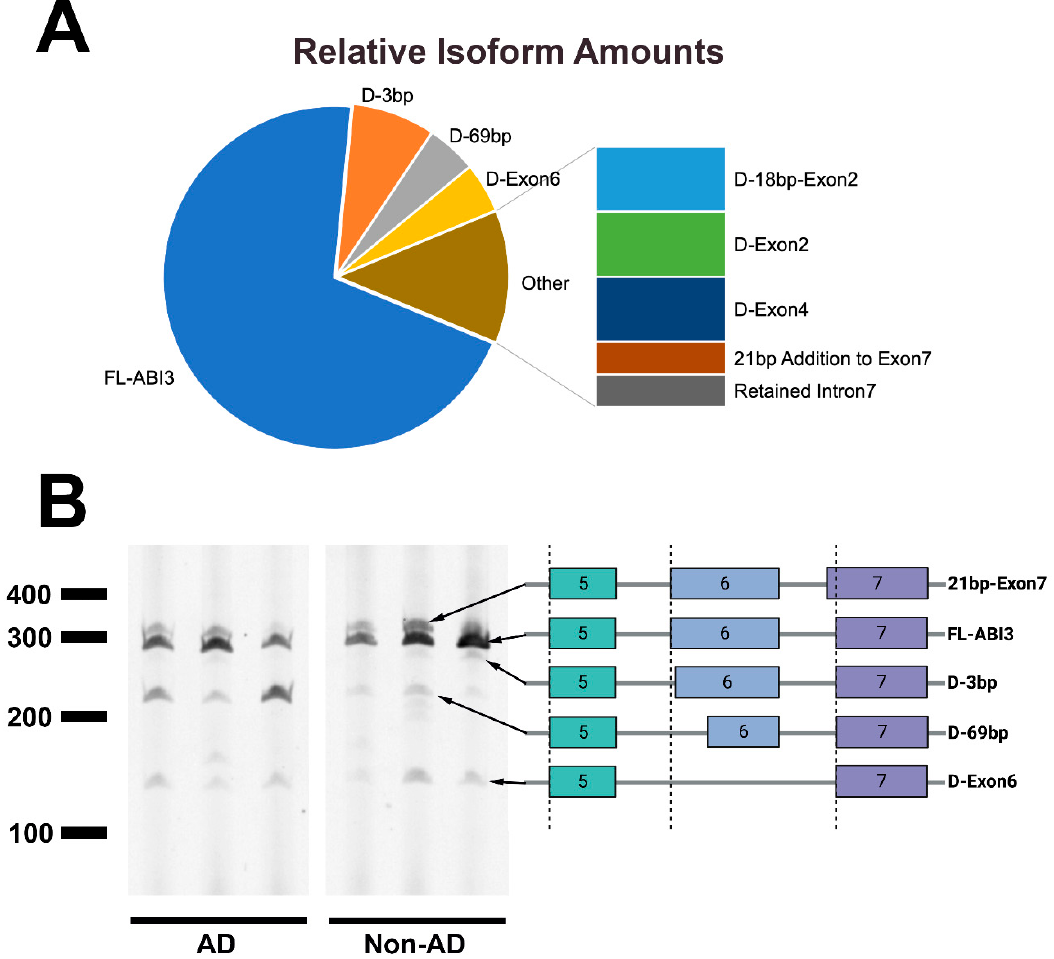
Figure 2. ABI3 isoforms present in human brain. Common ABI3 isoforms were identified by PCR amplification from exons 1 to 8 and sequencing random clones. In addition to the exon 6 isoforms, other isoforms include a loss of 18bp at the end of exon 2 ( D-18bp-Exon2 ), a deletion of exon 2 ( D-Exon2 ), a deletion of exon 4 ( D-Exon4 ), a 21 bp addition to the beginning of exon 7 ( 21bp Addition to Exon 7 ), and a retention of intron 7 ( Retained Intron 7 ) ( A ). Multiple exon 6 isoforms are present in AD and non-AD brain cDNA. The structure of each of these isoforms from exons 5 through 7 is indicated ( B